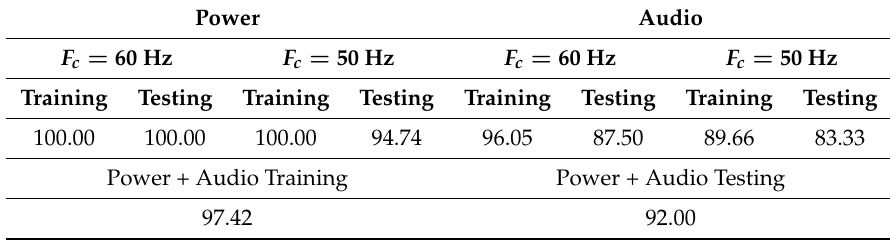
Figure 6. Proposed hierarchical structure for classifying 50 Hz audio data. Table 10. Training and Testing Accuracies (%) for 60 Hz and 50 Hz Power and Audio Recordings.